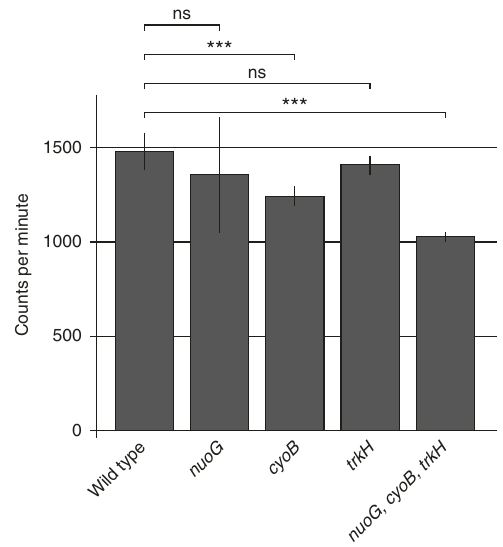
Fig. 4 Intracellular uptake of H3-dihydrostreptomycin. Cells from late exponential phase were incubated 30 min in presence of 50 nCi ml − 1 tritiated dihydrostreptomycin and washed to remove extracellular H3- dihydrostreptomycin. Counts per minute were determined for two biological and two technical replicates each. The error bars represent standard deviation. t -tests were performed to calculate the signi fi cance of the differences between mutants and wild type, where ns (not signi fi cant) indicates a p- value over 0.05 and three asterisks indicate high signi fi cance with p- values<